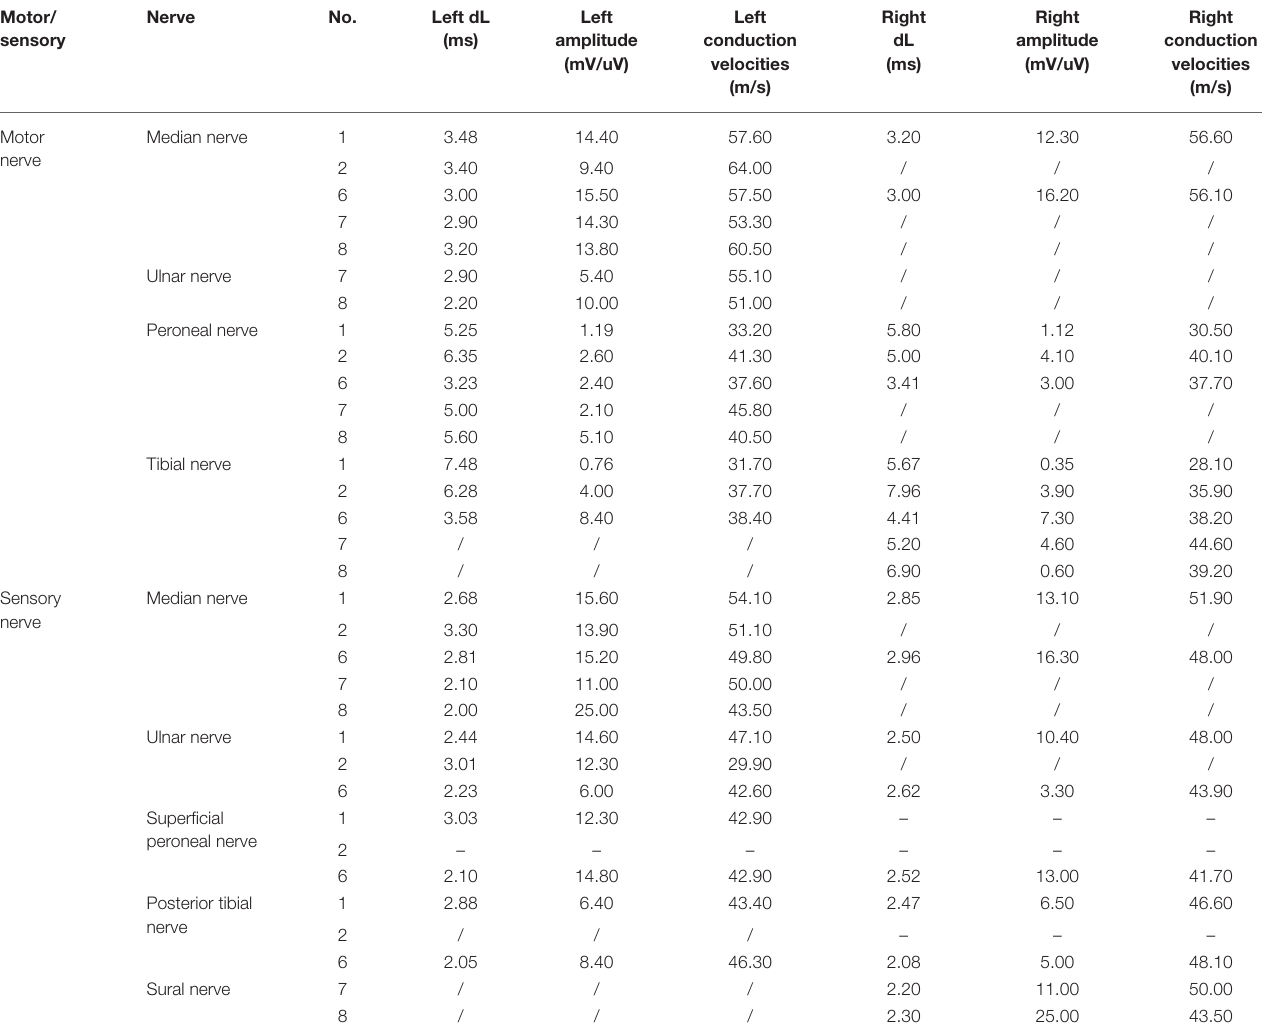
TABLE 3 | Electrophysiological data in 5 late-onset cblC patients. Motor/ Nerve sensory